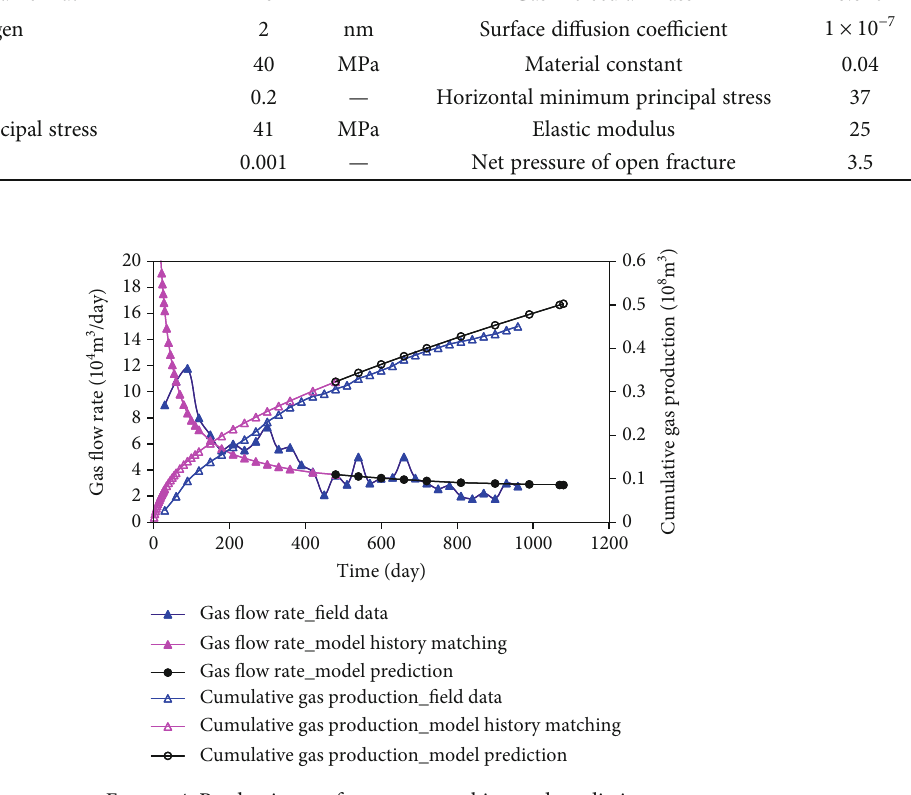
Figure 4: Production performance matching and prediction. Table 2: Considering di ff erent transport mechanisms in shale